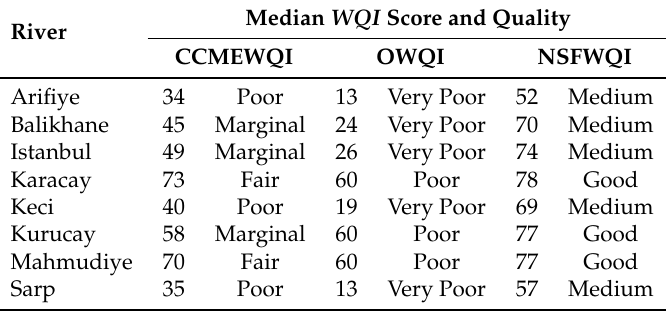
Table 5. Comparison of different Water Quality Indices for the rivers of Sapanca Lake Basin